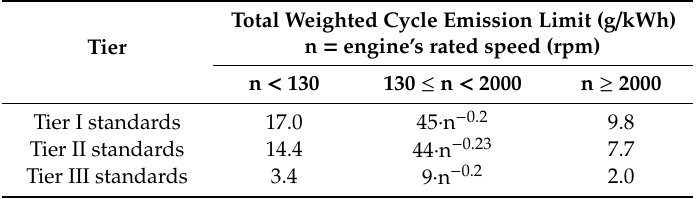
Table 1. MARPOL Annex VI NO X emission limits.